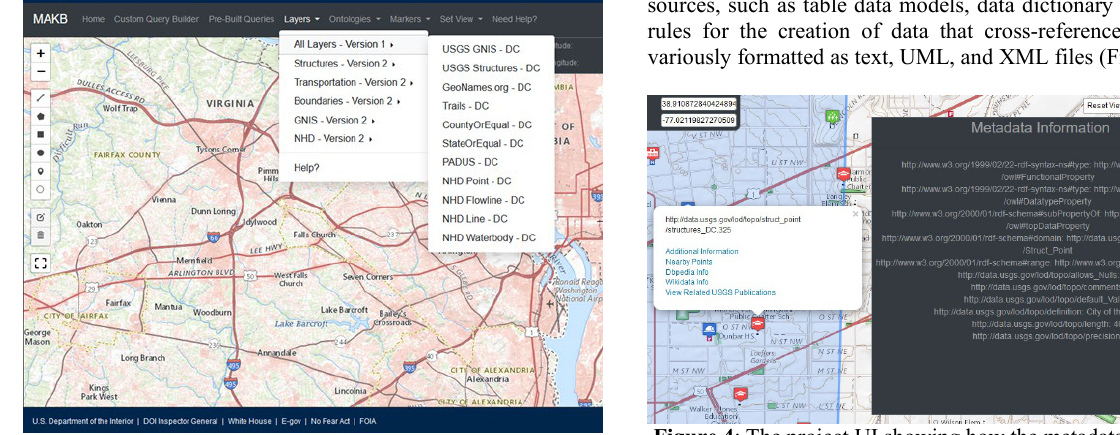
Figure 2 . Initial list of available datasets